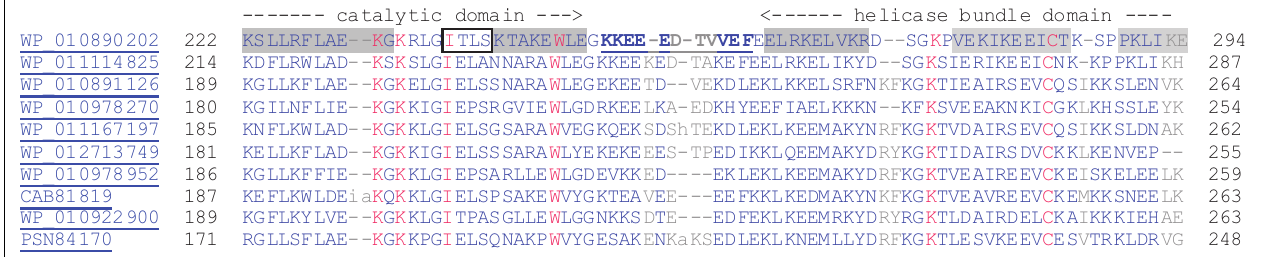
FIGURE 3 | Alignment of the region between the catalytic domain and the HBD of the pRN1 replication enzyme with homologous archaeal replication proteins, including those encoded by mobile genetic elements (pRN1, pRN2, pMEN7, and pDL10). The sequence of the pRN1 replication protein is given in the first line with helices highlighted with gray background and the beta-strand boxed. The residues in the linker sequence which could not be resolved in the crystal structure (pdb: 31M1) are underlined and bold. The alignment was generated with COBALT at a 4 bit threshold for